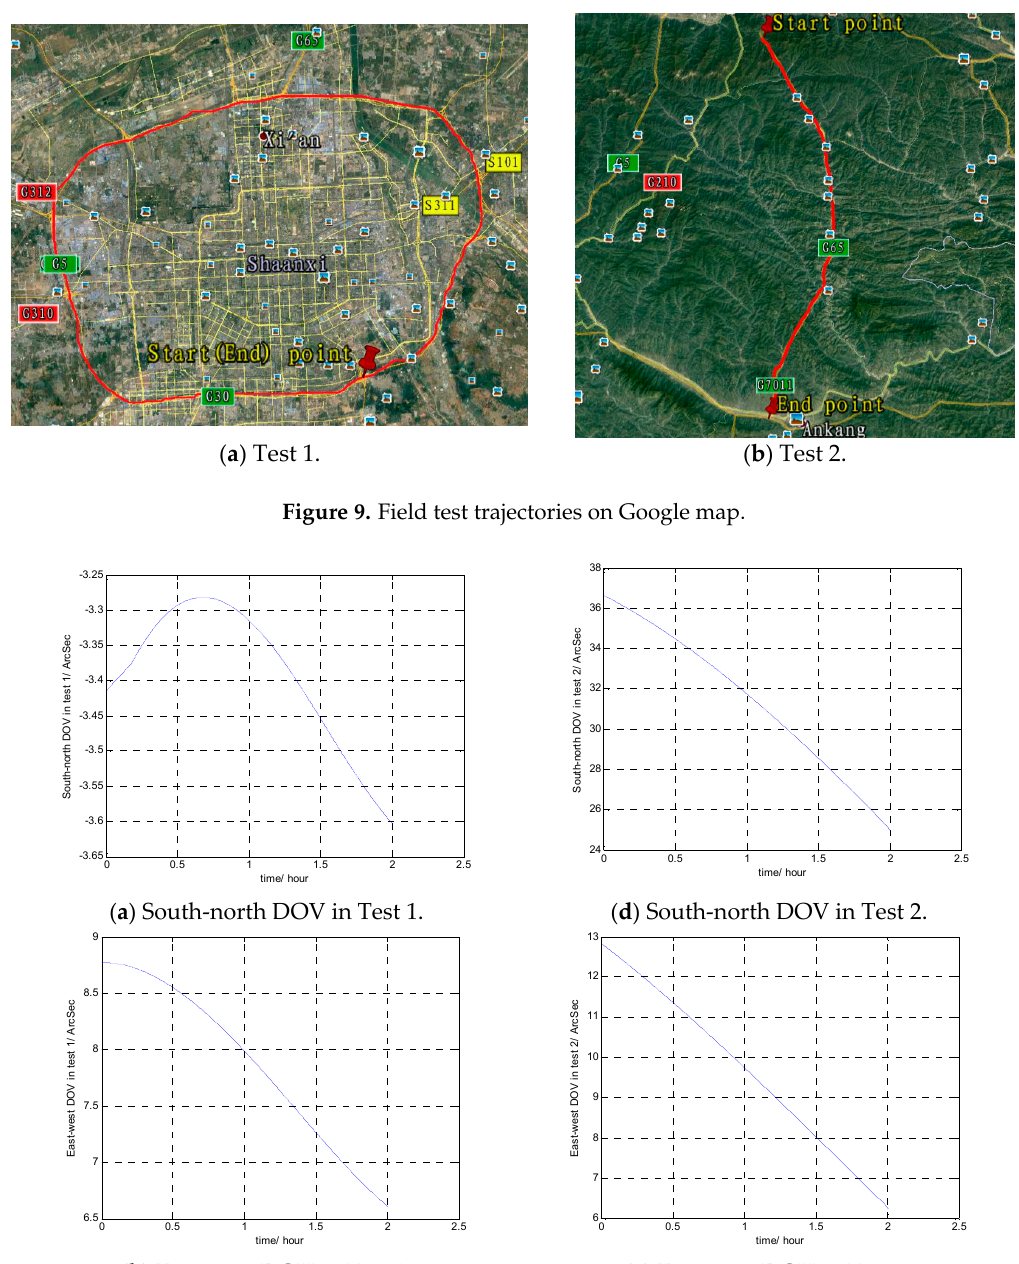
Figure 8. Field test device. PSC, processing computer system.